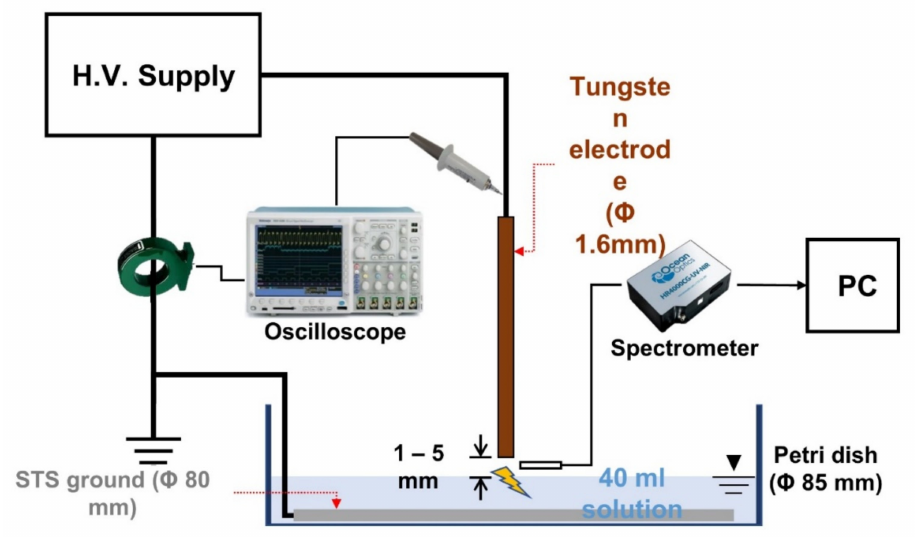
Figure 6. The schematic diagram of the plasma